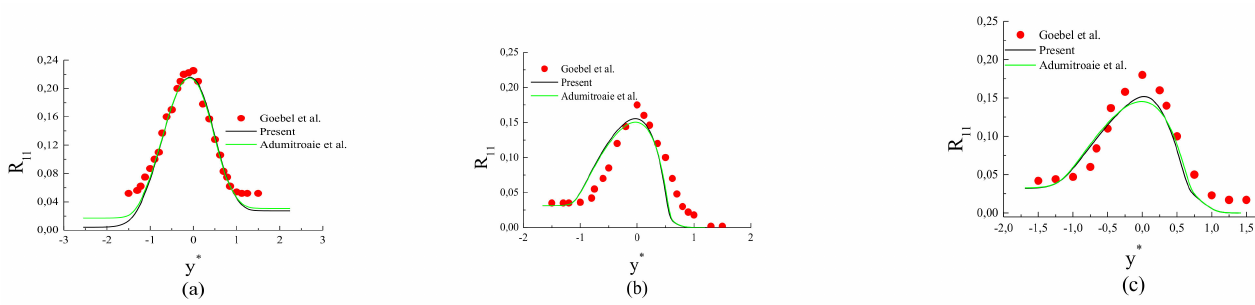
Figure 11. Similarity profiles of R 11 in the cases: ( a ) M c = 0.2, ( b ) M c = 0.69, and ( c ) M c =